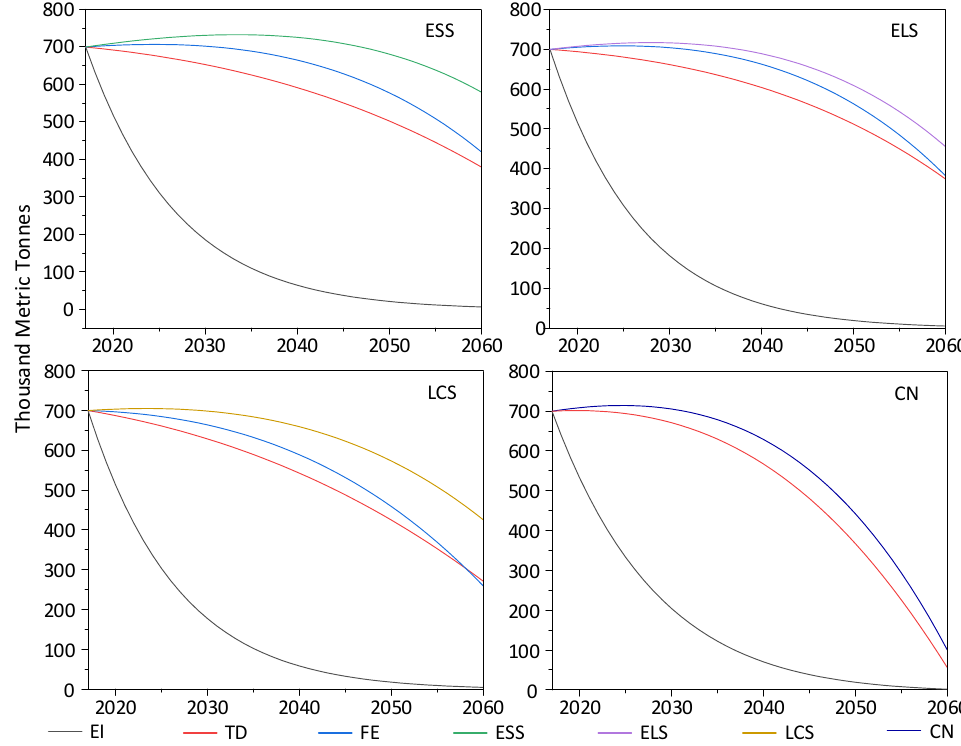
Figure 7. Sensitivity analysis results of the transportation sector under four scenarios (Unit: TMt). As for energy intensity, in ESS-EI, ELS-EI, LCS -EI, CN-EI, when energy intensity is reduced by 10%, there is no peak year and CO 2 emissions are on a dramatically downward trend. In the peak year under different scenarios, the peak value of CO 2 emissions will be reduced by 597.0 TMt in 2033, 492.0 TMt in 2028, 330.7 TMt in 2025 and 492.0 TMt in 2023, respectively; it is 81.5%,68.66%, 46.93% and 68.7% lower than the peak value under four scenarios, respectively. As for public transportation development, in ESS-TD, ELS-TD and LCS -TD, when individual transportation is decreased by 10%, there is no peak year and CO 2 emissions are also on a downward trend. In the peak year under different scenarios, the peak value of CO 2 emissions will be reduced by 95.6 TMt, 47 TMt and 32.8 TMt; it is 13.1%, 6.56% and 4.7% lower than the peak value under three scenarios, respectively. In CN -TD, individual transportation is decreased by 10%. In this sub-scenario, 2020 is the peak year and the peak year is five years earlier than CN. The peak value of CO 2 emissions is 701.2 TMt; it is 1.8% lower than the peak value under CN in 2023. As for the share of fossil fuels, in ESS-FE, when proportion of fossil fuels is reduced by 10%, the peak year is 2024 and the peak value of CO 2 emissions is 706.6 TMt; it is 3.5% lower than the peak value under ESS in 2033. The peak year is 9 years earlier than in the ESS scenario. In ELS -FE, when the proportion of fossil fuels is reduced by 10%, the peak year is 2025 and the peak value of CO 2 emissions is 708.5 TMt; it is 1.1% lower than the peak value under ESS in 2028. The peak year is 3 years earlier than in the ELS scenario. In LCS -FE, when the pro- portion of fossil fuels is reduced by 10%, the peak value of CO 2 emissions will be reduced by 14.5 TMt; it is 2.1% lower than the peak value under LCS. In CN -FE, when the propor- tion of fossil fuels is reduced by 10%, the peak year is 2023, 9 years earlier than in the CN scenario. In 2023, the peak value of CO 2 emissions will be reduced by 9.9 TMt; it is 1.4% lower than the peak value under CN. To sum up, energy intensity plays the dominant role in decreasing CO 2 emissions of the urban transportation sector under cold climatic conditions. In ESS, CO 2 emissions can